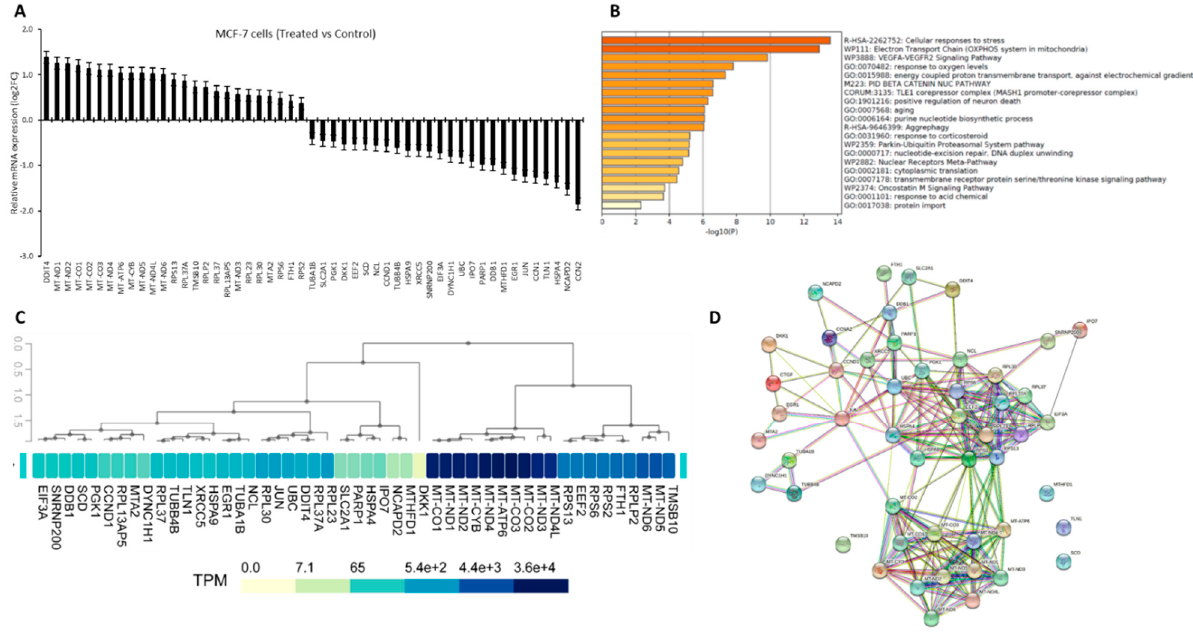
Figure 1. Crocodylus porosus serum-induced differentially expressed targets genes in breast cancer cells. ( A ). Relative mRNA expression of 51 differentially expressed genes (DEGs) in breast cancer cells treated with crocodile serum versus the control untreated cells. All plotted genes were statistically significant in comparison to the control. ( B ). Pathway enrichment analysis using DEGs as input genes. ( C ). Heatmap showing expression of DEGs in normal human breast tissues from GTEx. ( D ). Diagram showing protein-protein interactions amongst the DEGs encoded proteins.